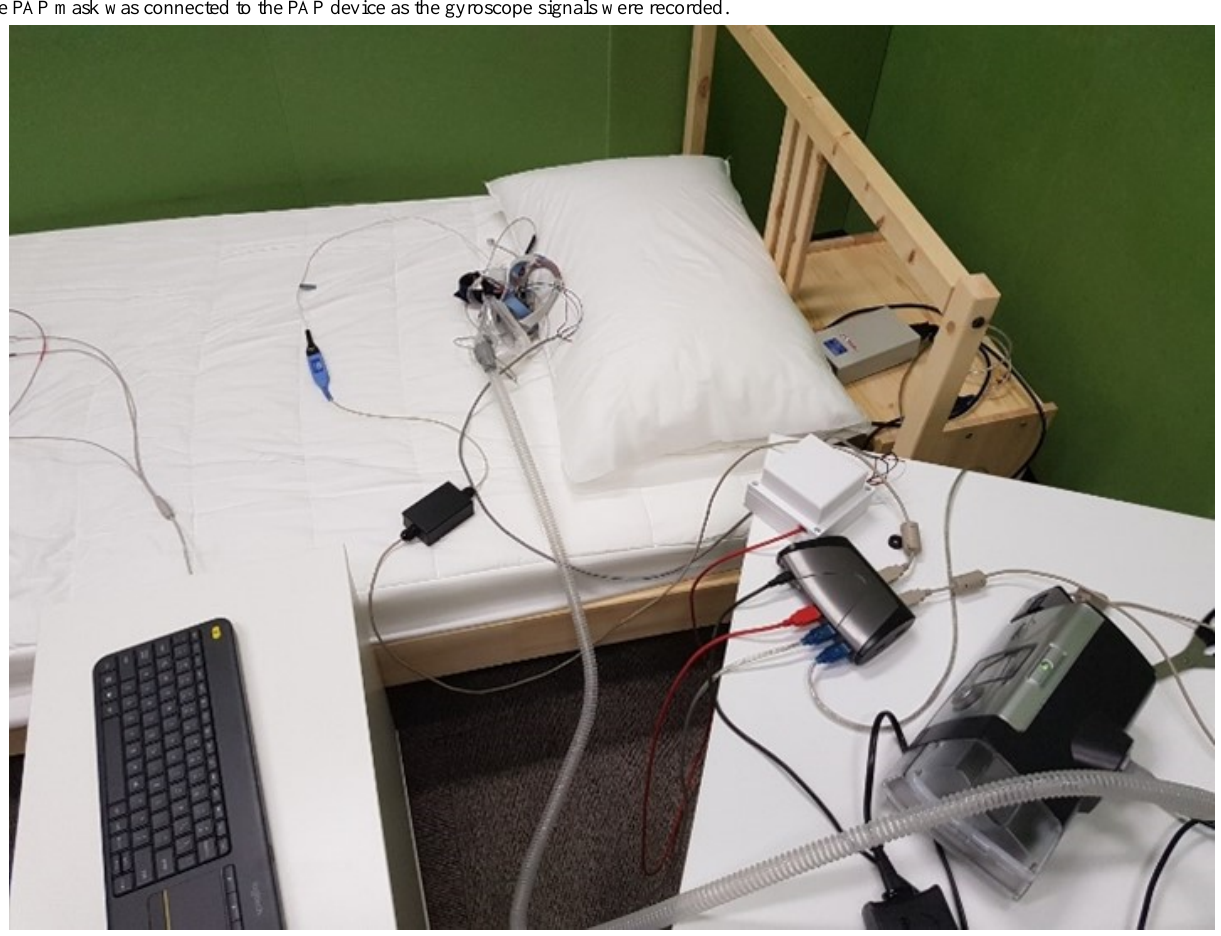
Figure 2. The experiment setup. The participant will wear the modified positive airway pressure (PAP) mask and lie on the bed in the required orientation. The PAP mask was connected to the PAP device as the gyroscope signals were